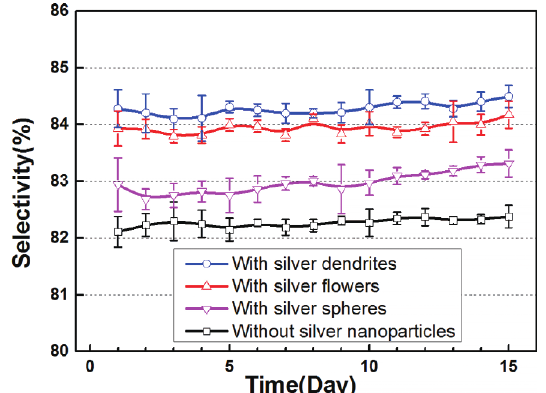
Fig. 9 Reaction selectivity of ethylene epoxidation catalyzed by silver. In the preparation of supported catalyst, sil- ver particles with different morphologies are added into the silver slurry and loaded on the alumina sup- porter, which results in the different selectivity at the same loading capacity of silver.